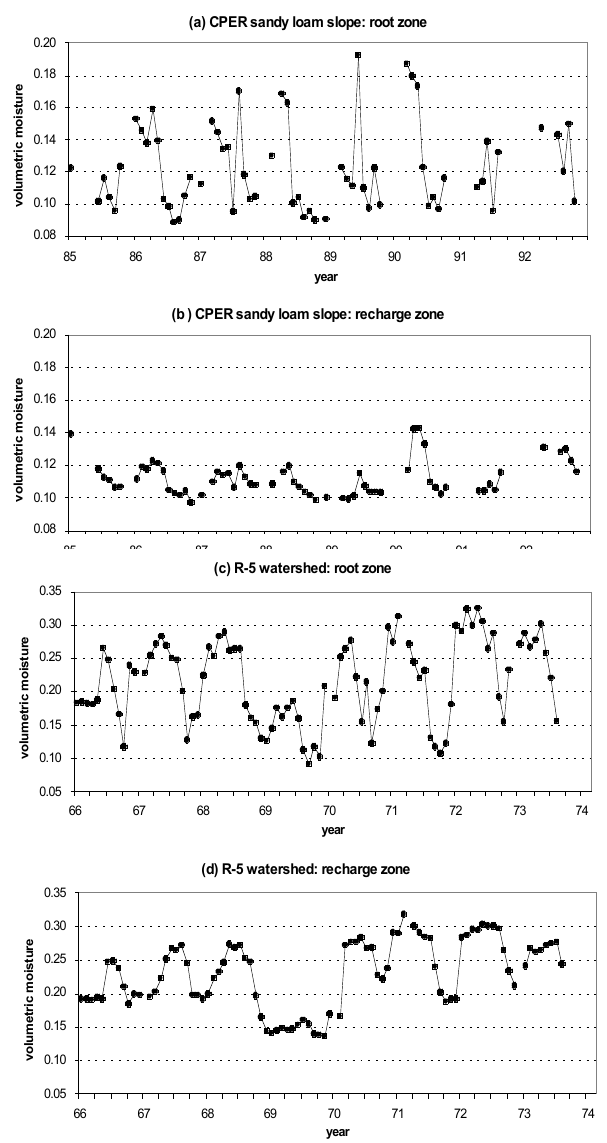
Fig. 6. Monthly averages of observed volumetric soil moisture at the two grassland sites: (a) root zone at the CPER (measurements made at depths of 30 and 45cm), (b) recharge zone at the CPER (measurements made at depths of 60, 75 and 90cm, (c) root zone at the R-5 watershed (measurements made at depths of 15, 30, 45 and 60cm), and (d) recharge zone at the R-5 watershed (measurements made at depths of 75, 90, 105 and